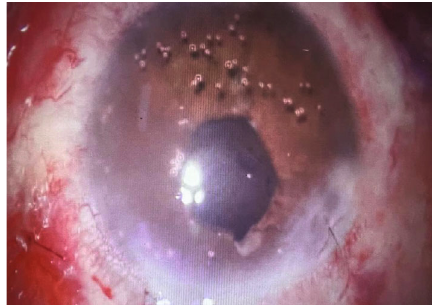
Figure 9: The intraocular lens was centered and the pupil was round after double haptic sutureless scleral interlamellar fi